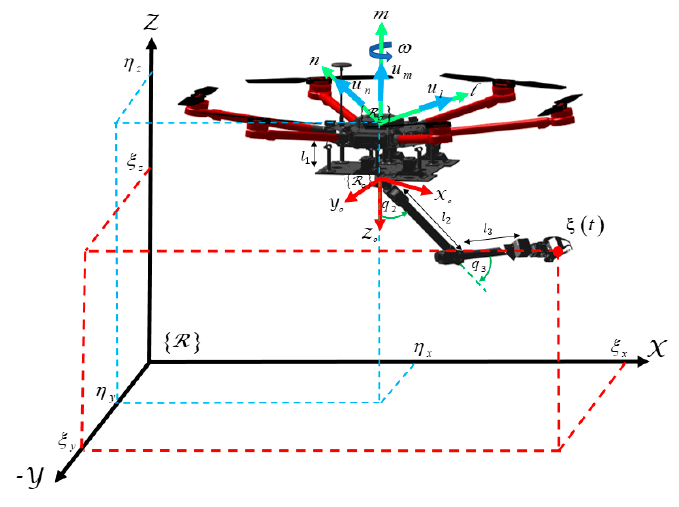
Figure 1. Aerial manipulator robot schematic.